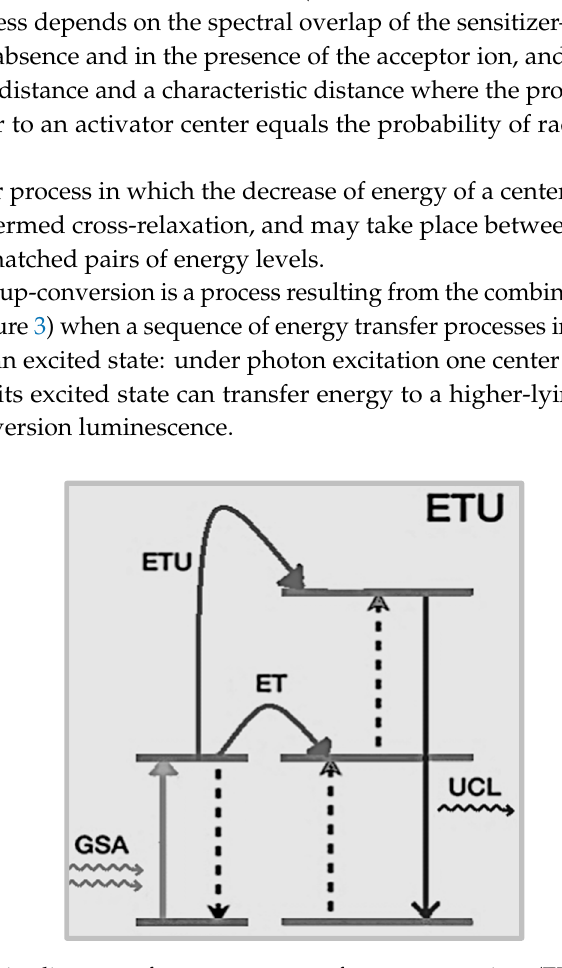
Figure 3. Schematic diagram of an energy transfer up-conversion (ETU) process involving ground state absorption (GSA), energy transfer (ET) between emitting centers, and up-conversion luminescence